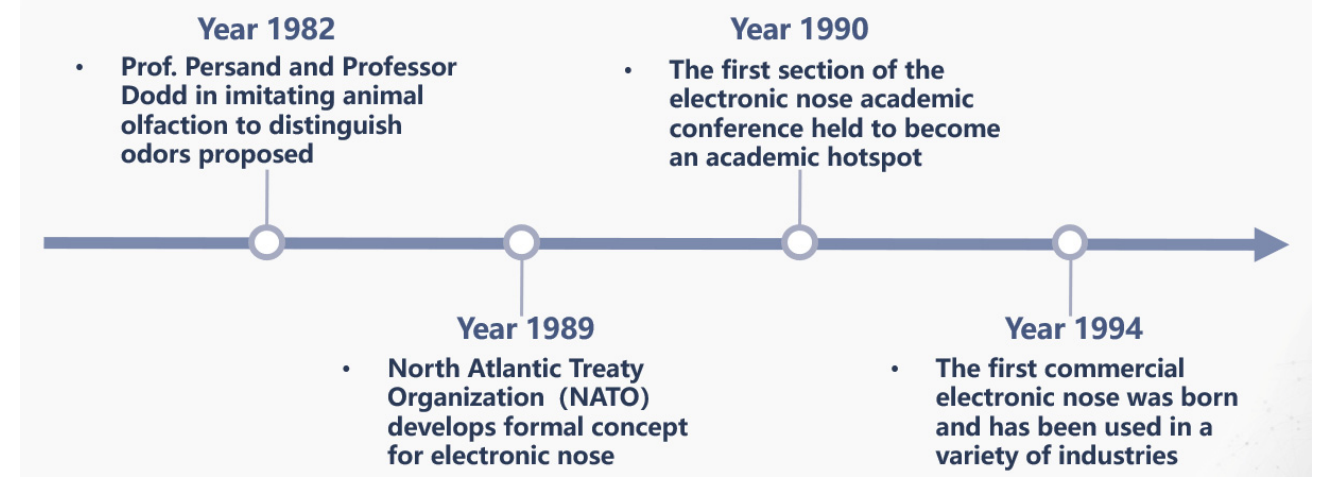
Figure 1. Electronic nose development history.